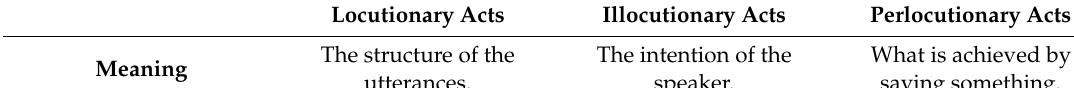
Table 1. The speech acts, their meaning, and evaluation. Locutionary